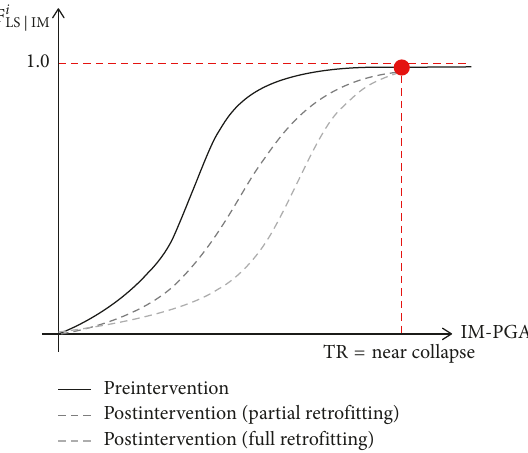
Figure 3: Pre- and postfragility curves: (a) status quo, (b) partial retrofitting, and (c) full retrofitting.